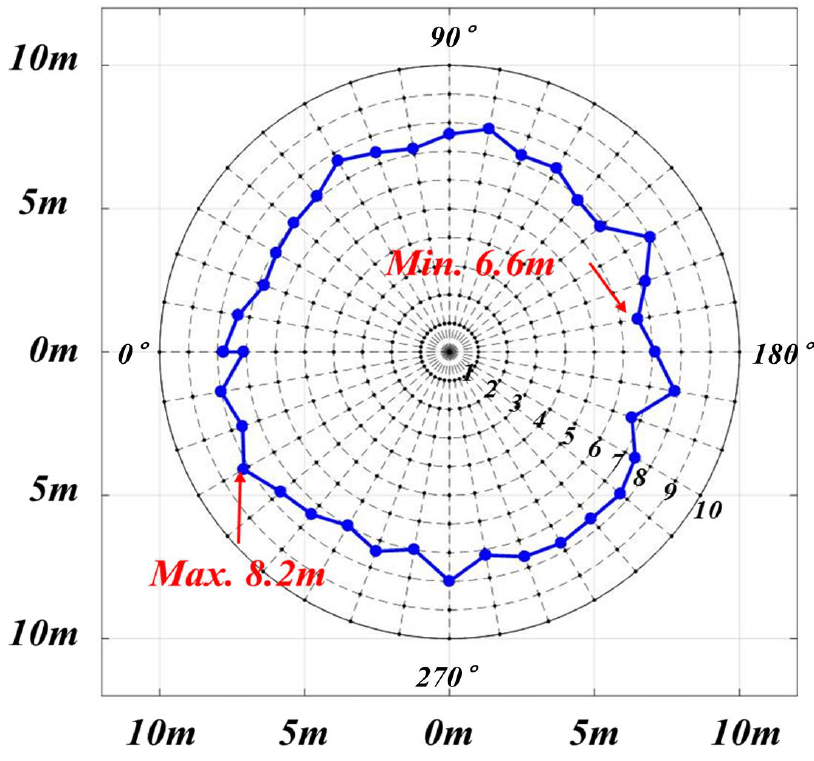
Figure 15. Result of dynamic test. Table 10. Real distance of PPU detection by UMCU (dynamic test).